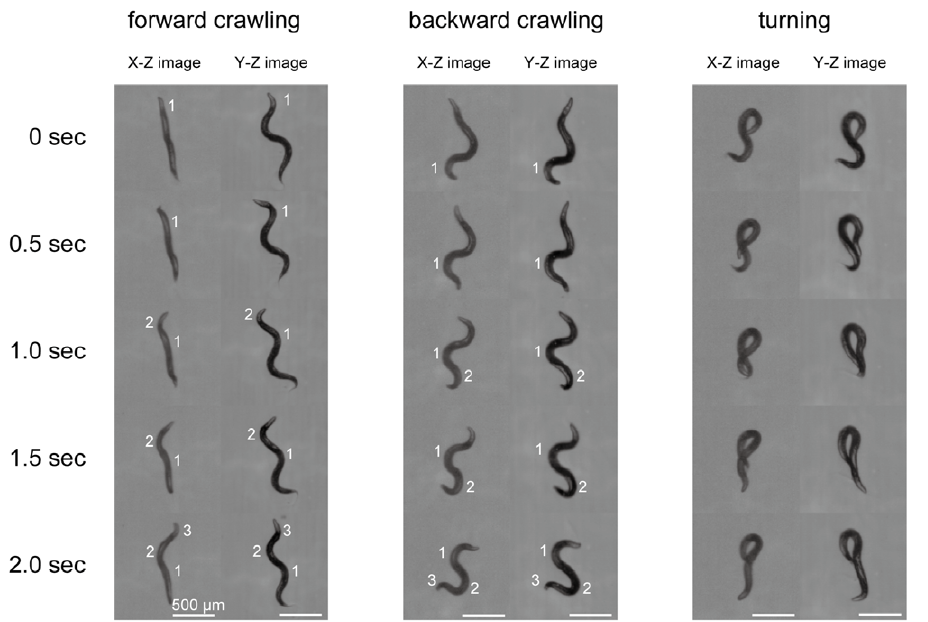
Figure 3. Motion of a worm in a 3-D environment. Stereoscopic images of a worm crawling forward, crawling backward, and turning. The numbers indicate bends in order. Scale bars represent 500 m